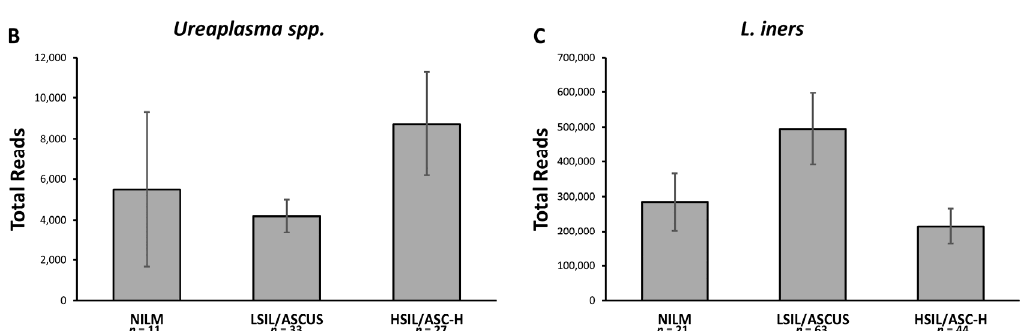
Figure 2. Relative abundance of Mycoplasma based on cervical cytology. Abundance among infected is the mean of positive 16s samples ( n ) adjusted by prevalence determined by PCR screen. Error bars represent standard error of the mean. ( A ) Expected number of M. hominis 16s DNA reads for 100 Tanzanian women of varying cervical cytology; ( B ) Expected number of Ureaplasma spp. 16s DNA reads for 100 Tanzanian women of varying cervical cytology; ( C ) Expected number of L. iners 16s DNA reads for 100 Tanzanian women of varying cervical cytology.